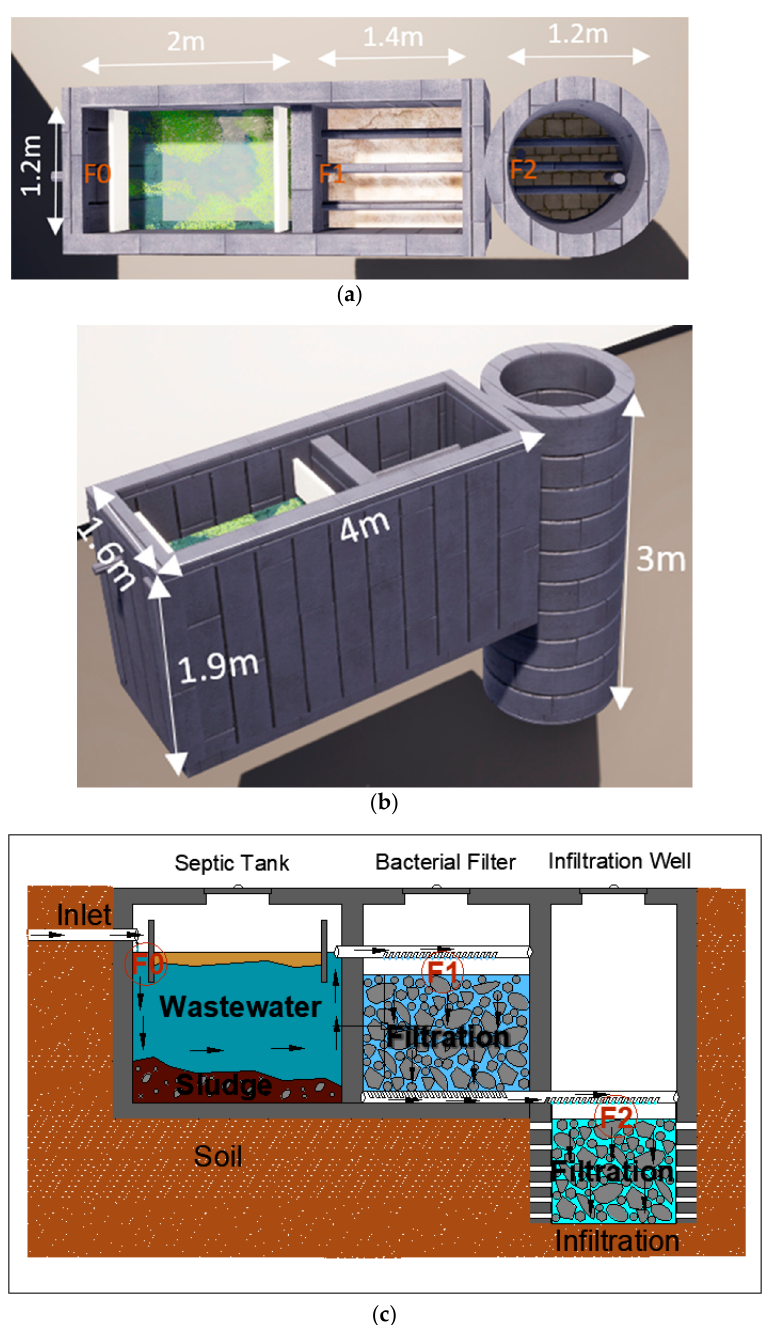
Figure 1. Three-dimensional dimensions of the wastewater treatment plant (WWTP) prototype. ( a ) Top view of the WWTP prototype; ( b ) longitudinal view of the WWTP prototype; ( c ) operating outline of the WWTP prototype.